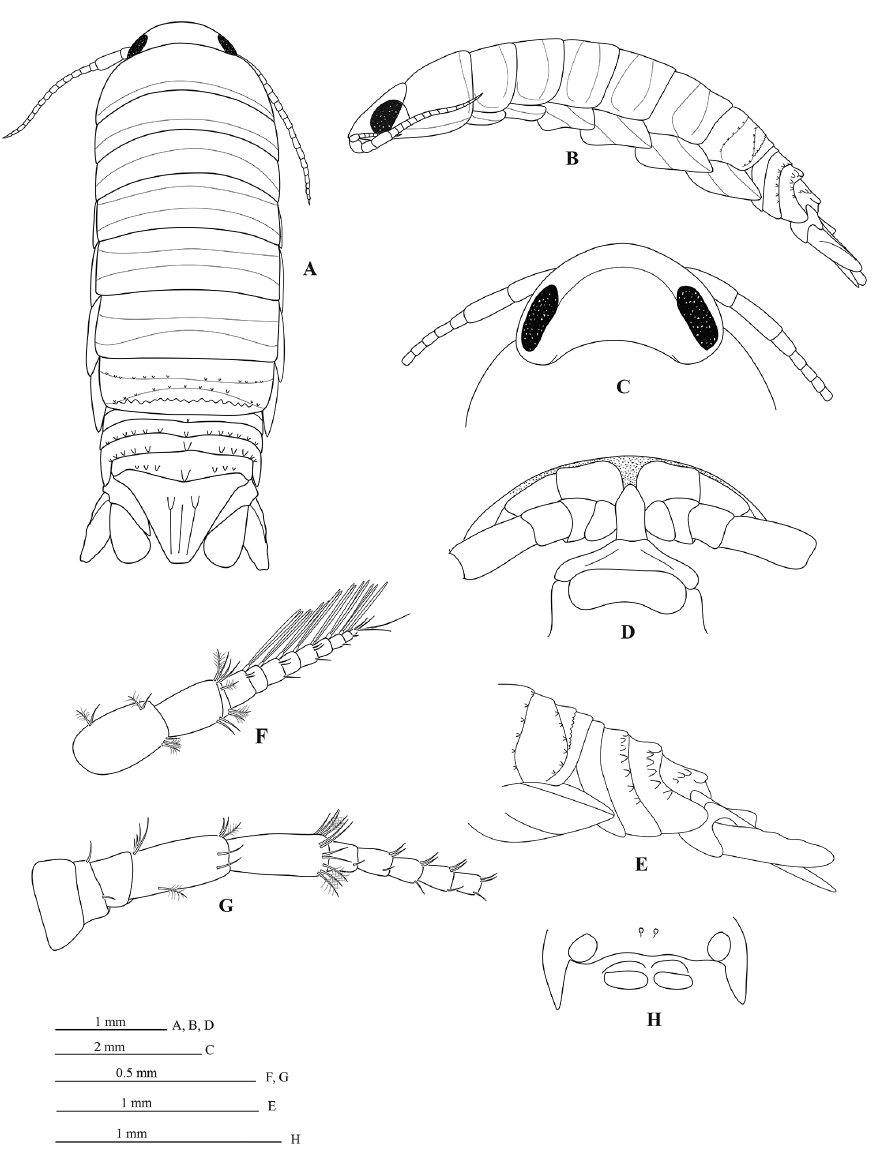
Figure 2. Cirolana phuketensis sp. n., male holotype, (PSUZC–CR0286-01) (5.0mm) ( A–E ), male para- type (PSUZC–CR0286-02) (5.1 mm) ( F–G ), male paratype (PSUZC–CR2086-04 ( H ) A dorsal view B lateral view C head D frons E pleon F antennula G antenna peduncle H penial opening, sternite beyond posterior margin of pleonite 5; pleonite 5 with prominent median tubercles and 3–4 sublateral tubercles on each side, posterolateral angles overlapped by lateral margins of pleonite 4. Pleotelson 0.7 times as long as anterior width, dorsal surface with 2 tubercles and paired submedian longitudinal carina; lateral margins weakly concave,